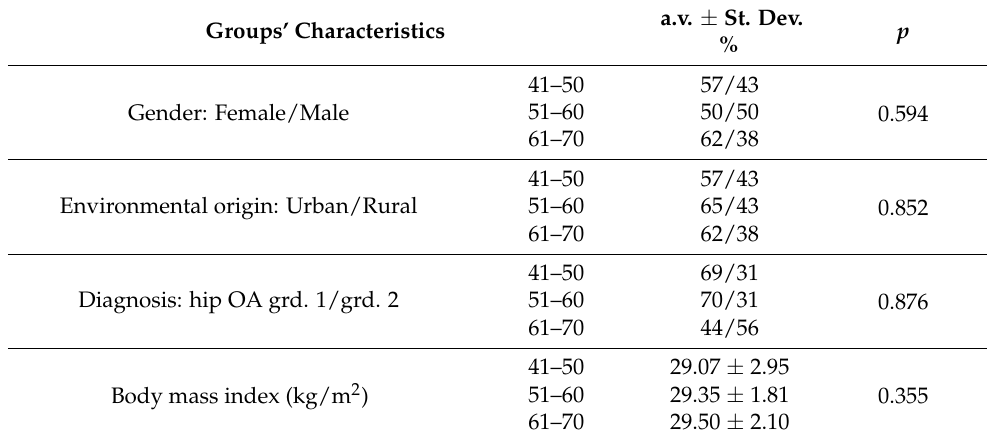
Table 4. Characteristics of the age groups.